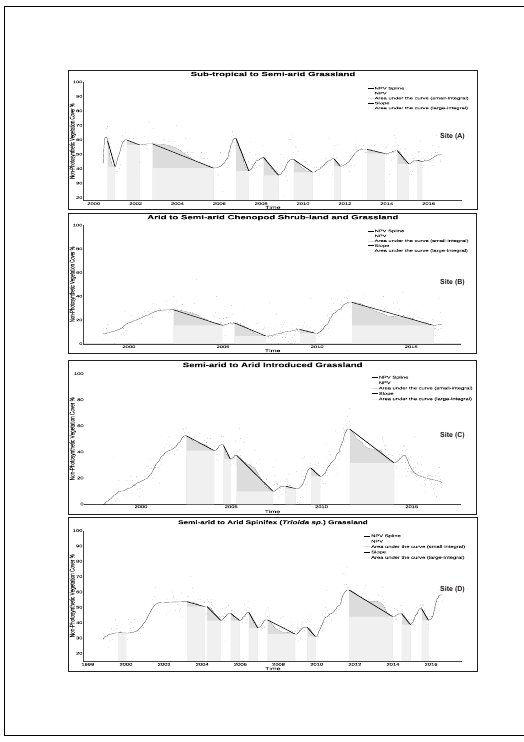
Figure 16. Individual pixel NPV time series plots of the four grassland field site image subsets. The monotonic trend of each utilisation stage is illustrated, indicating a majority of negative downward trends for each stage in each